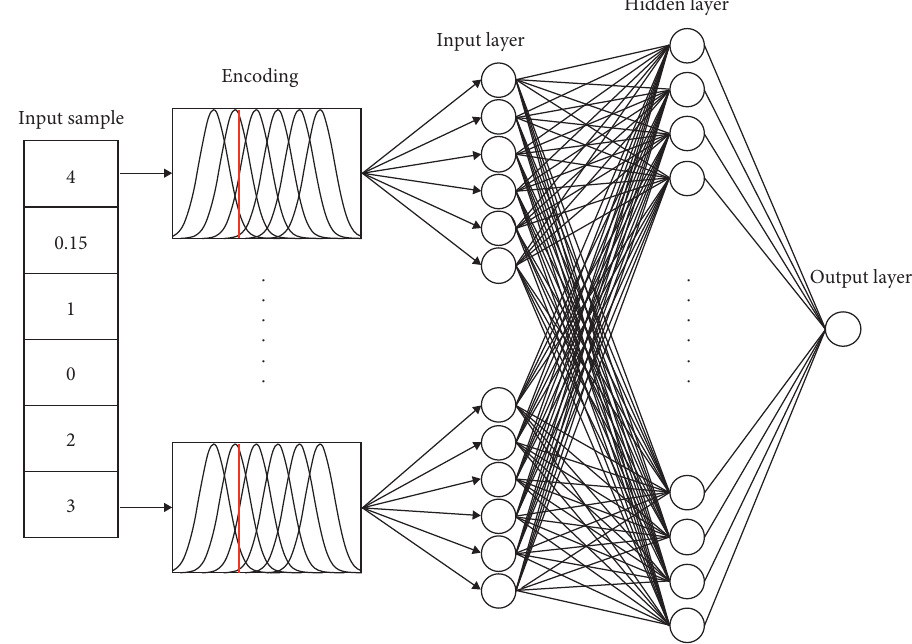
Figure 5: A Multi-ReSuMe-based SNNs classifier. Table 2: The target spike-time of output neuron corresponding to each cluster. Cluster